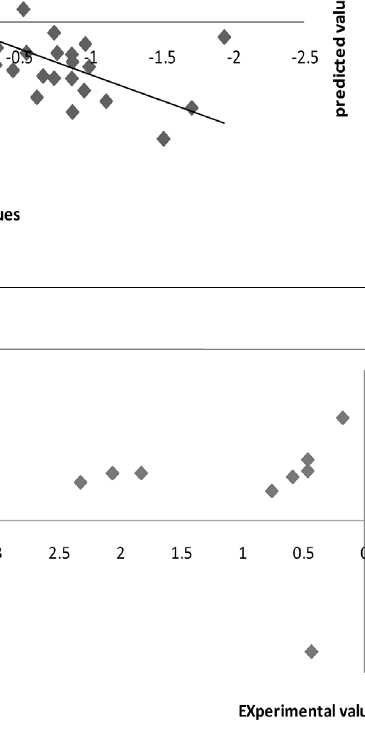
FIGURE 7 | Experimental pIC50 versus residual plot in external validation.